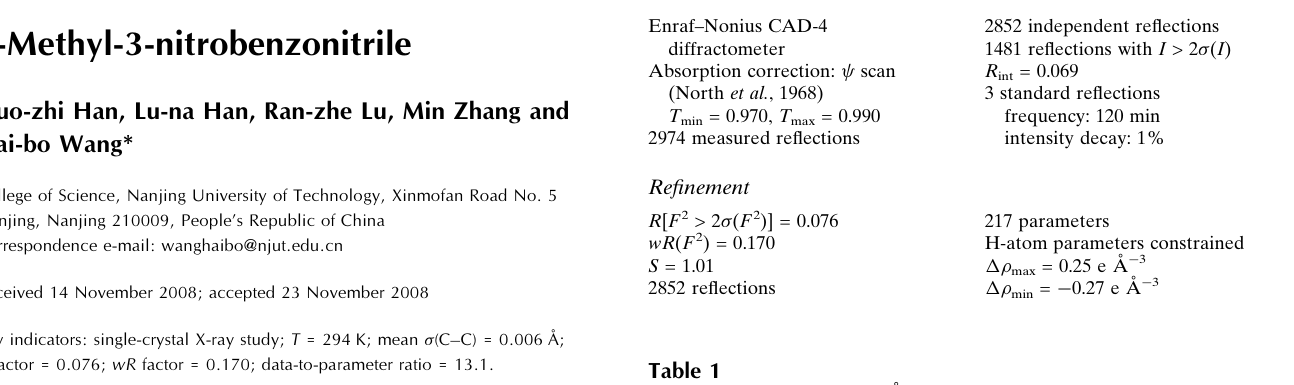
Hydrogen-bond geometry (A˚ , (cid:1)